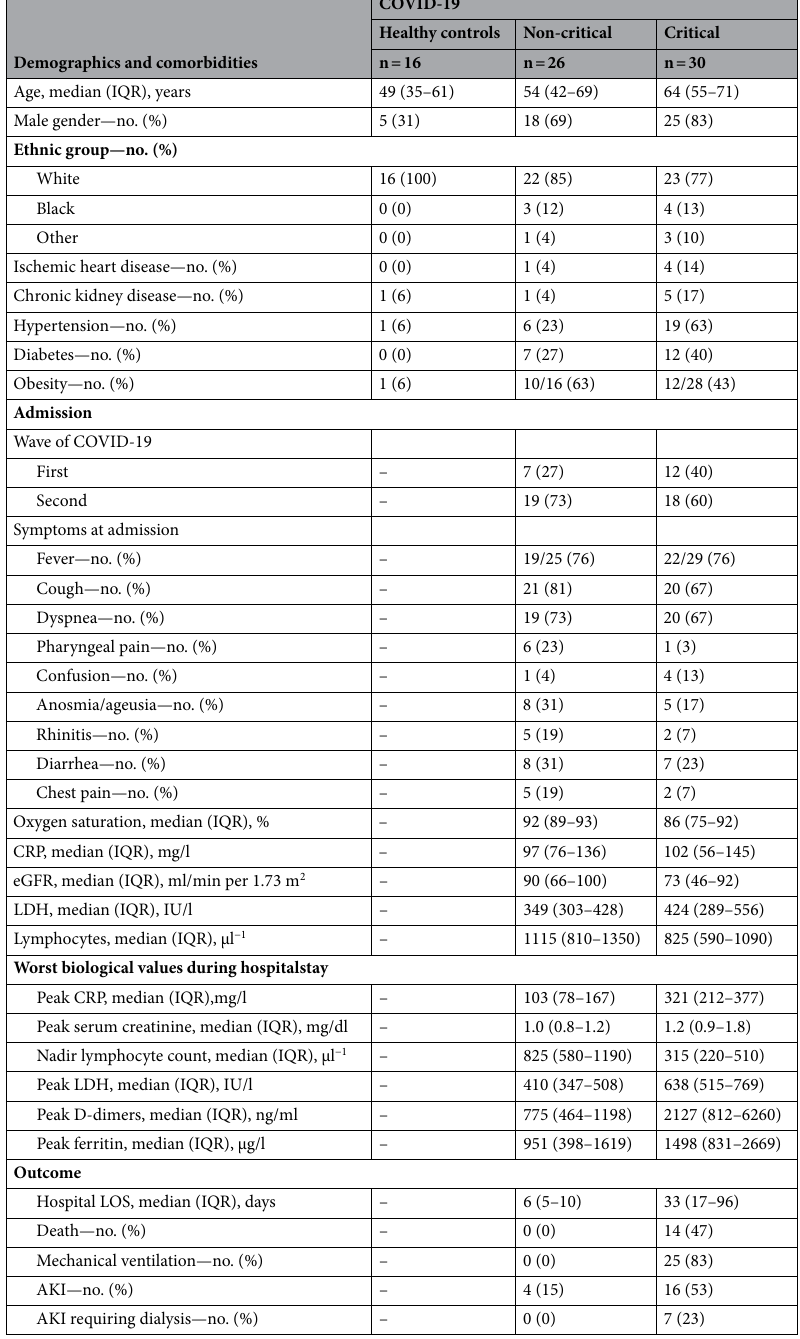
Table 1. Baseline characteristics of COVID-19 patients, stratified for disease severity. Continuous variables are expressed as median and interquartile range (IQR), and categorical variables as numbers (no.) and dehydrogenase; LOS, length of stay; AKI acute kidney